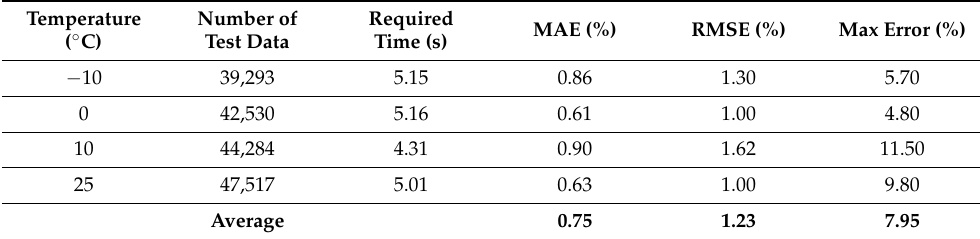
Table 6. Test Results of the hybrid CNN-GRU-LSTM model.